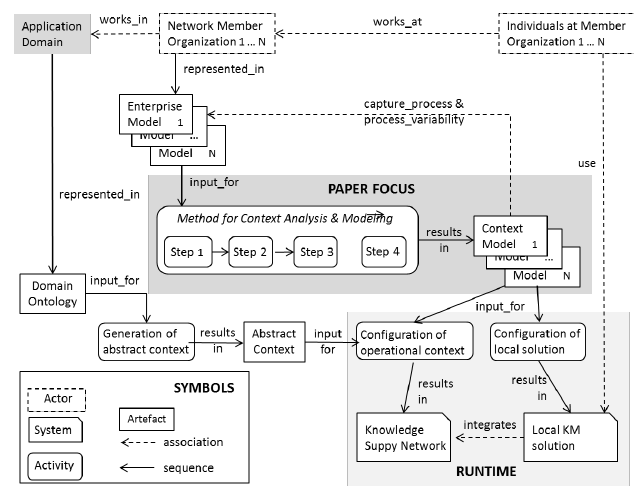
Fig. 2. Overview of the context analysis approach and related